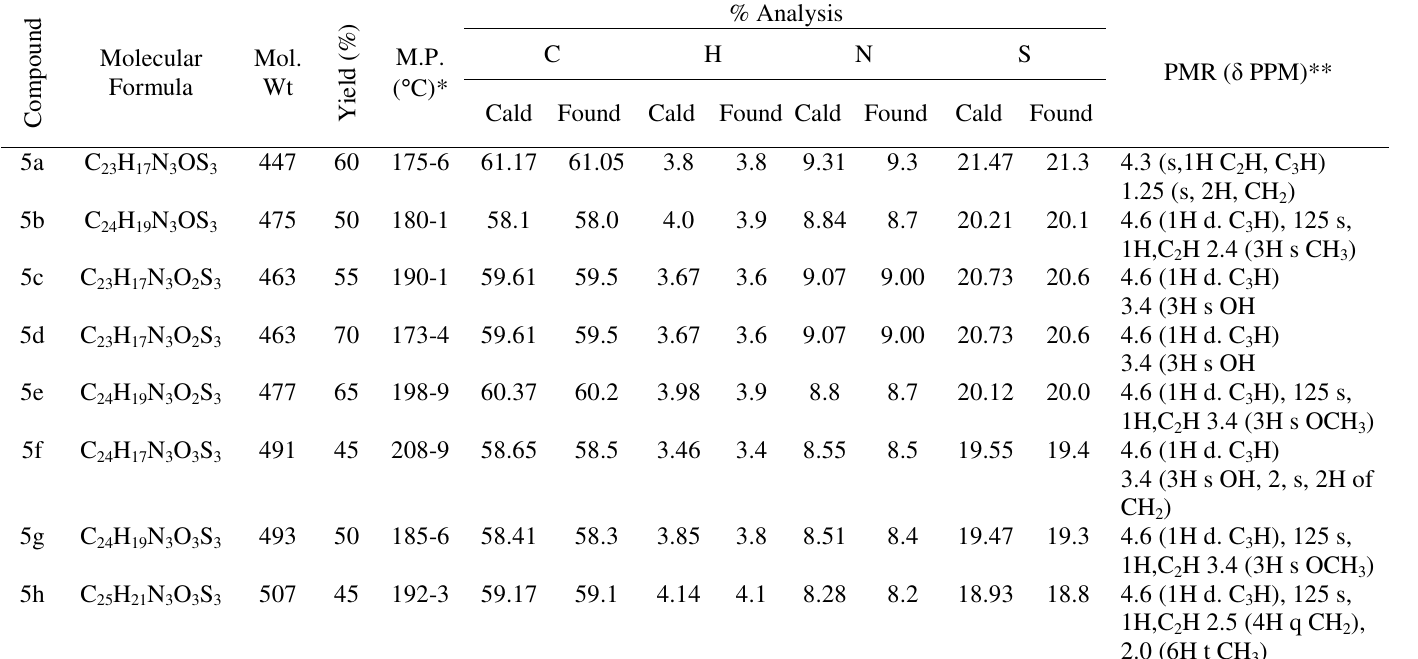
Table 2 . Analytical and spectral Data of Commands Thiazolidinones, 5a-h %